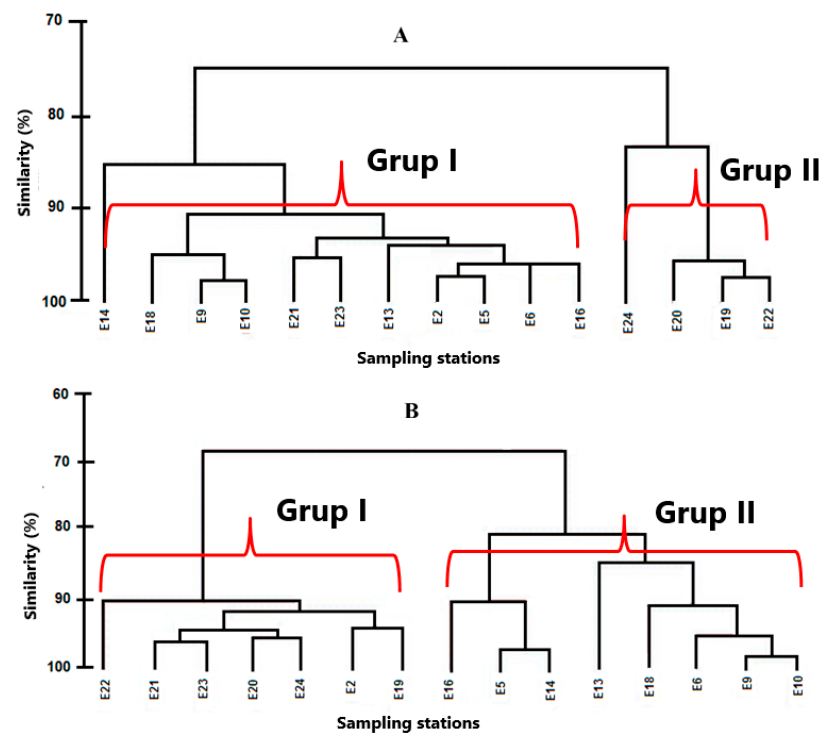
Figure 6. Grouping of the stations according to the quality of the water during the dry season ( A ) and rainy season ( B ).